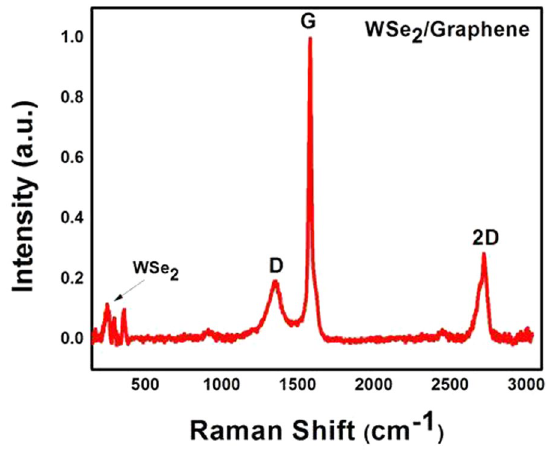
Figure 5. Raman spectra of the WSe 2 -graphene